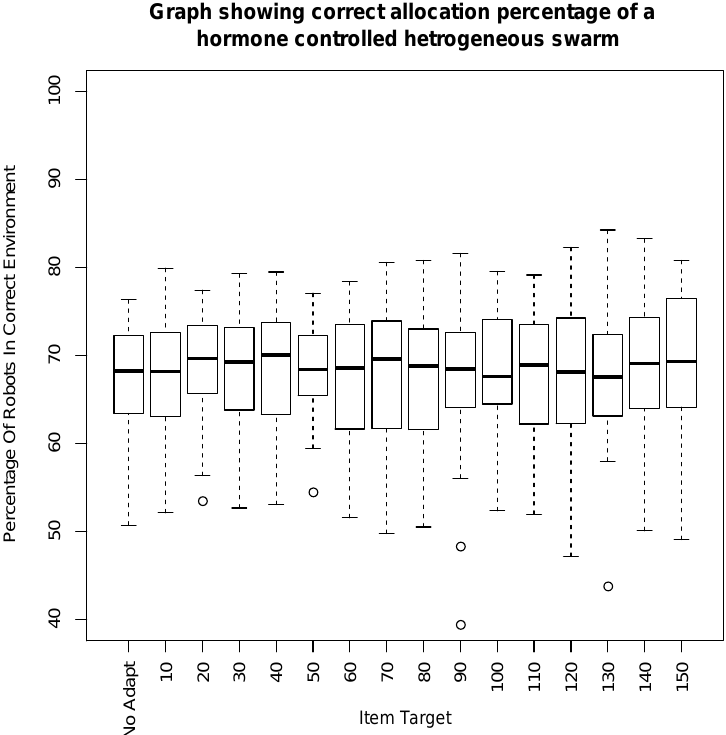
Figure 12. Effect of item target values driving different demands in the speed hormone on the percentage of robots taking preference to their optimal environment. The categorisation system running with no speed hormone present is marked as ‘no